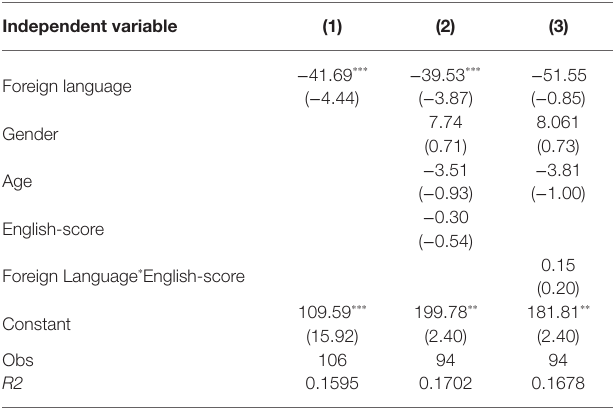
TABLE 3 | Regression analysis (dependent variable: payoff). Independent